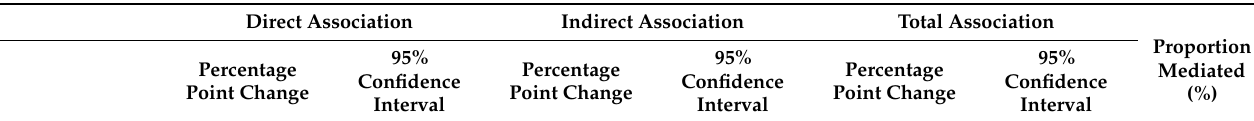
Panel A: Direct and indirect associations of the prenatal PM 2.5 exposure First